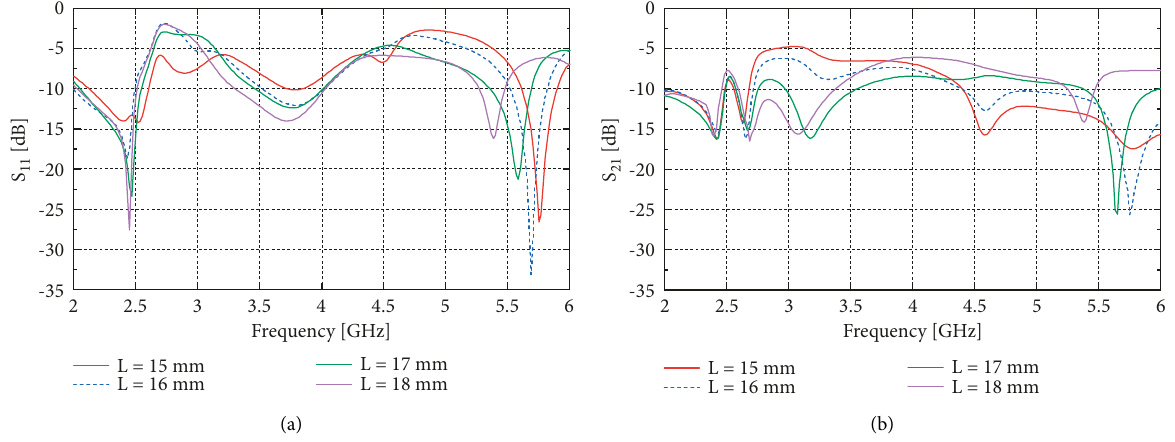
Figure 13: S-parameter of antenna#2 with different lengths of the NL: (a) S